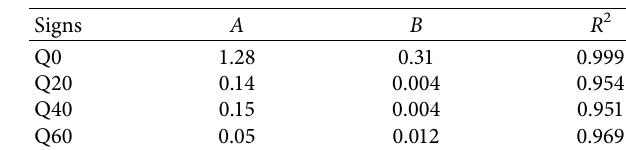
Table 6: Parameter fitting.